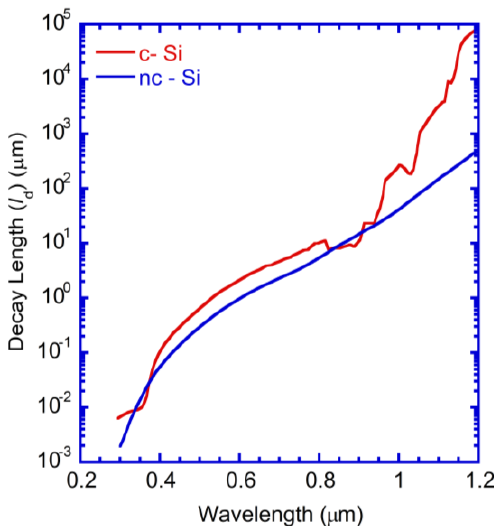
Figure 1. Photon absorption length as a function of wavelength for crystalline silicon (c-Si) and nano- crystalline silicon (nc-Si) (using the complex refractive index ( n , k ) parameters of Reference [26]).